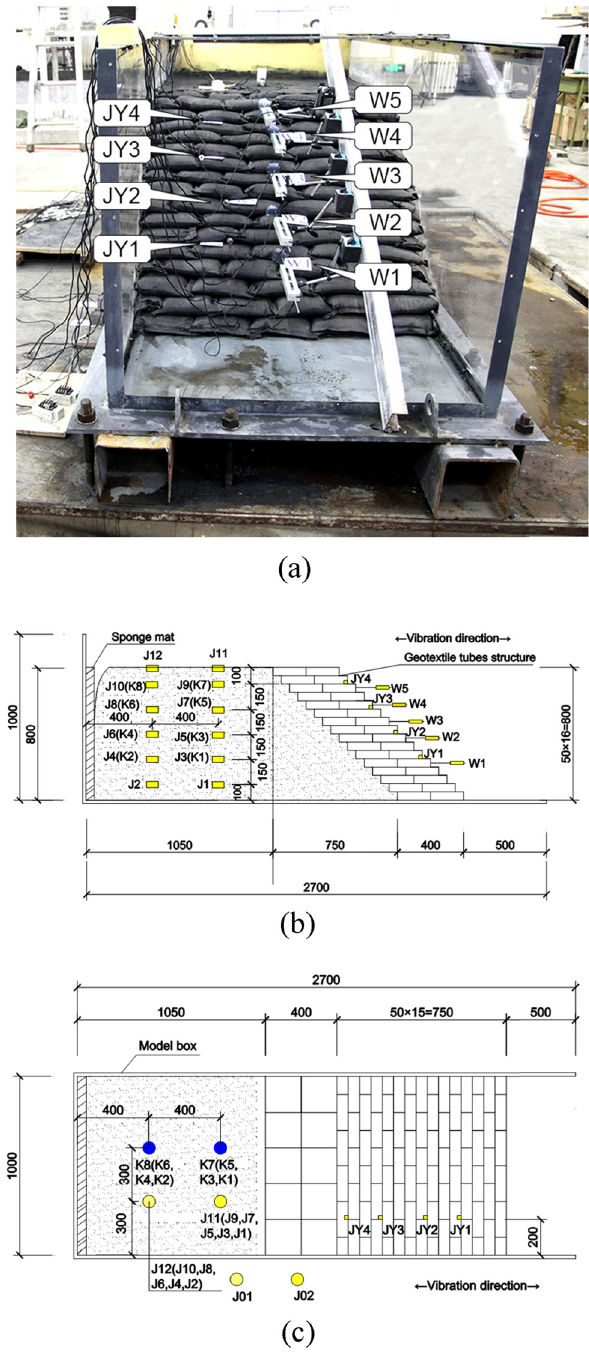
Figure 4: Typical sensor layout of shaking table test: ( a ) model dam; ( b ) schematic of longitudinal pro fi le of model; and ( c ) top view of